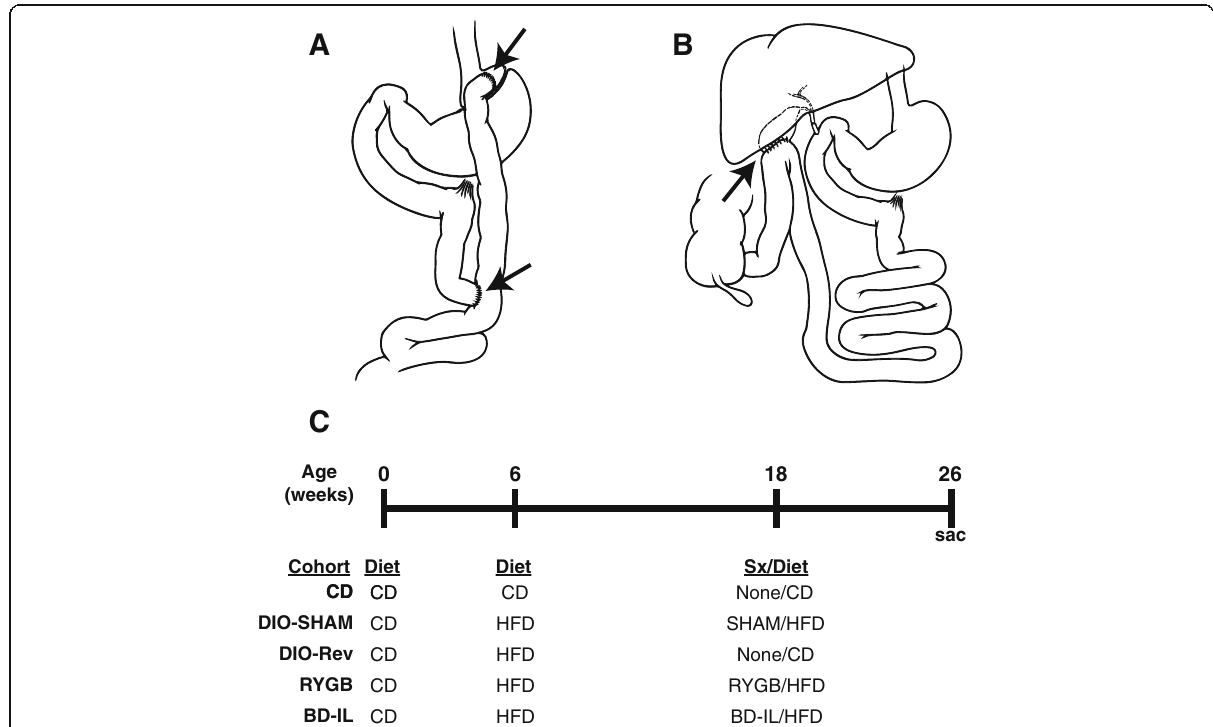
Fig. 1 Models of murine bariatric surgery and experimental design. a For Roux-en-Y gastric bypass (RYBG) procedure, the stomach was ligated between the gastric fundus (forestomach) and glandular portion while the jejunum was transected 4 cm from the Ligament of Treitz. The distal jejunum was subsequently anastomosed to the forestomach (top arrow) with GI continuity being maintained via a jejuno-jejunostomy 6 cm distal from the initial transection (lower arrow). Image modified from (Albaugh et al. 2016). b For the biliary diversion procedure (BD-IL), the common bile duct was ligated proximal to the pancreatic duct and the gallbladder anastomosed to the ileum 4 cm proximal to the ileo-cecal valve. Image modified from (Albaugh et al. 2016). c Experimental design. Age of mice shown in weeks with time of dietary changes and surgical procedures (Sx) shown at 6 and 18 weeks. All mice were sacrificed at 26 weeks of